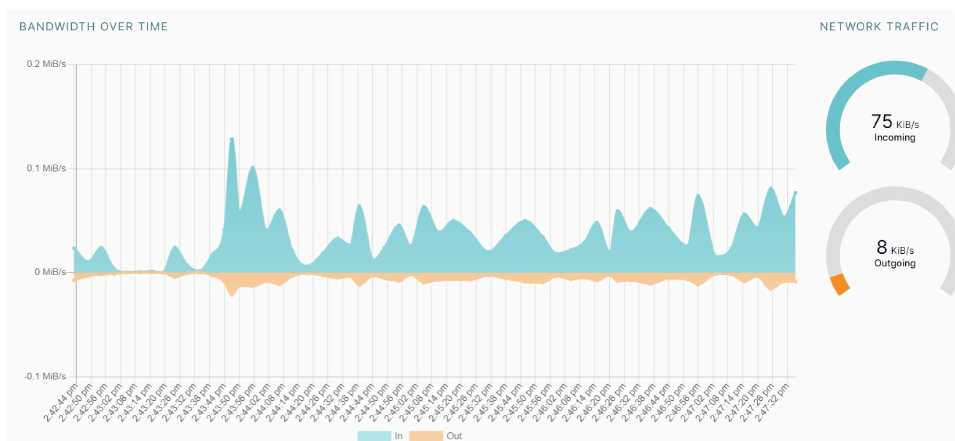
Figure 5. IPFS Network Status.